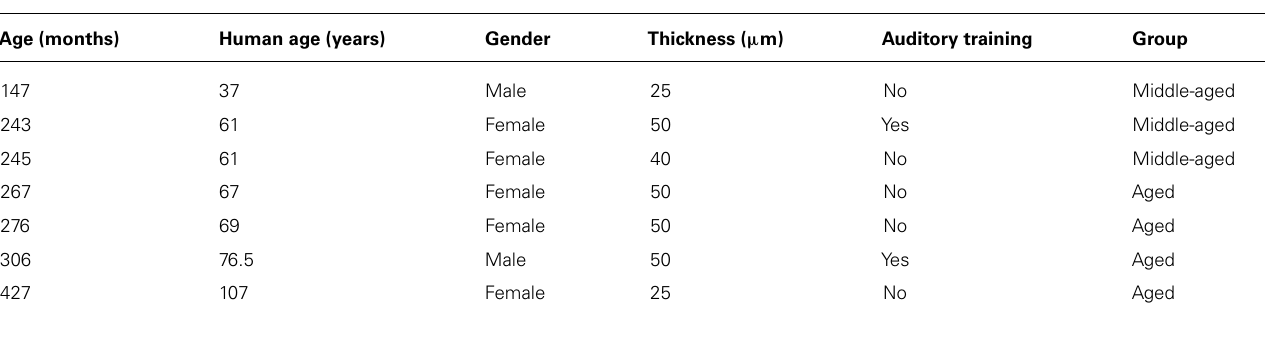
Table 1 | Demographics and information on the monkeys